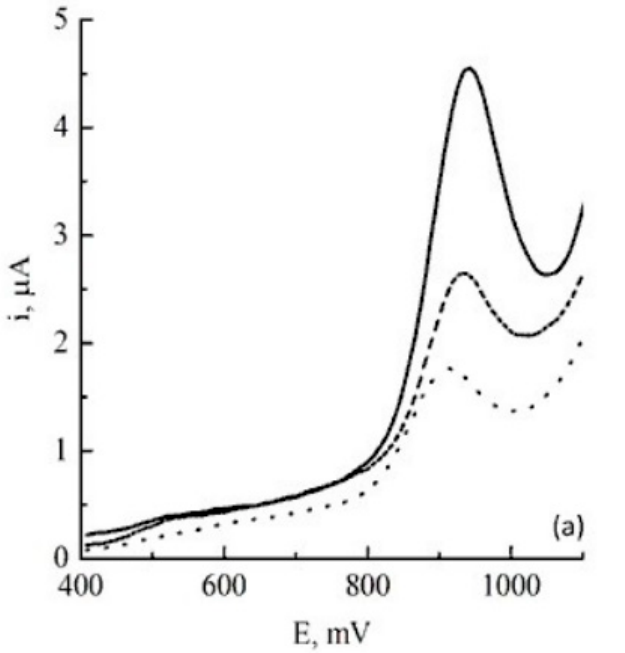
Figure 12. Square-wave voltammograms of Carmoisine solution on CPE (dash line), CPE/SG (dotted line). Reprinted with the permission of Reference [42]. [License Number 5070190415448]. Table 7. Table showing Carmoisine detection using carbon paste electrodes with different modifiers along with their de- tection limits.